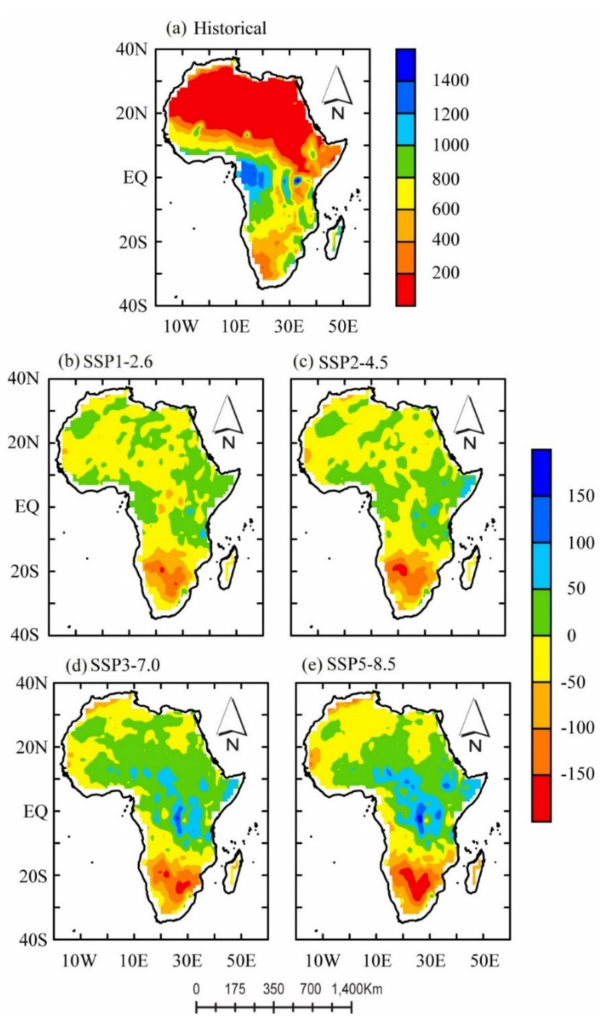
Figure 4. Spatial distribution of multi-year mean evapotranspiration ( a ) in the historical period (1995–2014) and ( b – e ) ET change in the future period (2020–2099) under the SSP1-2.6, 2-4.5, 3-7.0, and 5-8.5 scenarios relative to the historical mean. The unit is mm year − 1